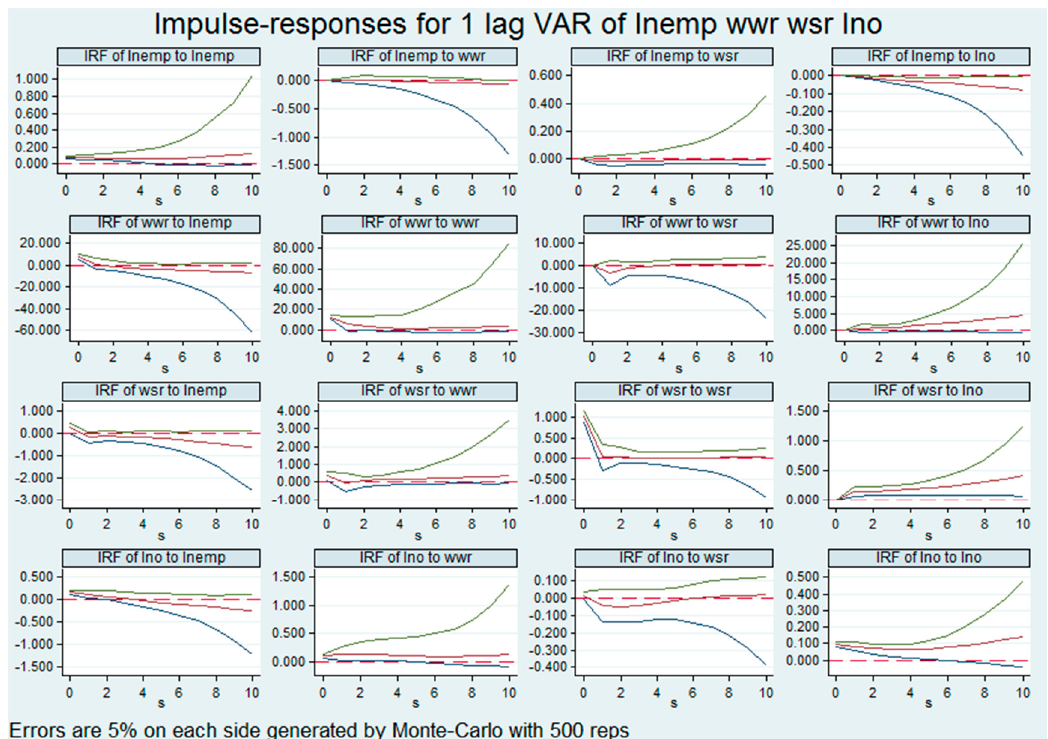
Figure 2. Clean industries impulse response function.